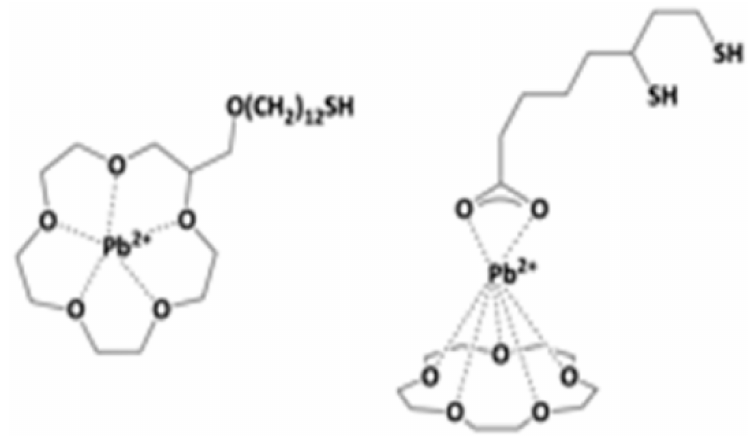
Figure 24. Examples of crown ethers supported onto Au NPs. Reproduced with permission from reference [141], Nanomaterials , MDPI.